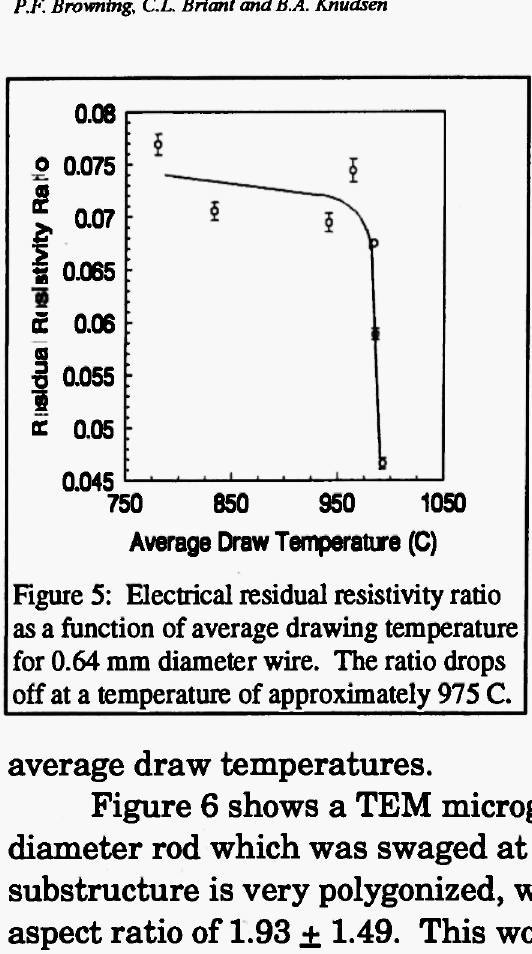
Figure 5: Electrical residual resistivity ratio as a function of average drawing temperature for 0.64 mm diameter wire. The ratio drops off at a temperature of approximately 975